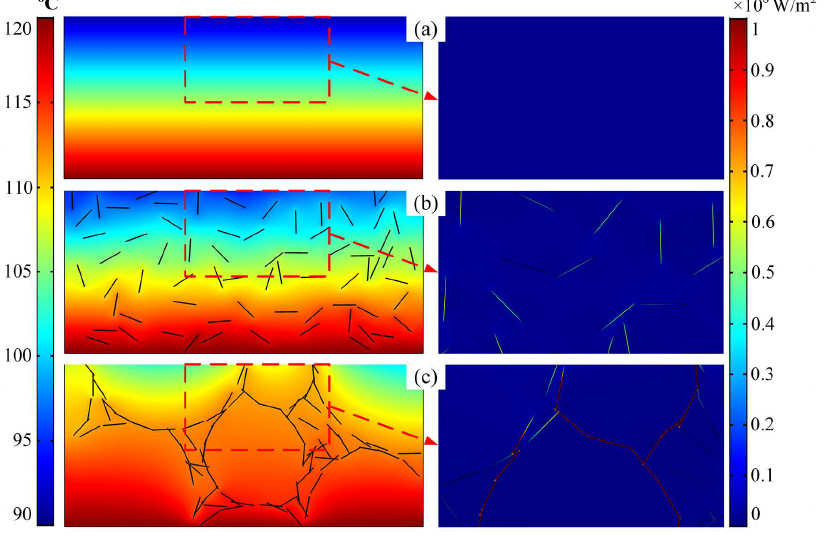
Figure 6. ( a – c ) Simulated temperature distribution ( left ) and heat flux distribution ( right ) of the T- composite, R/hBN-composite, and 3D/hBN-composite, respectively.